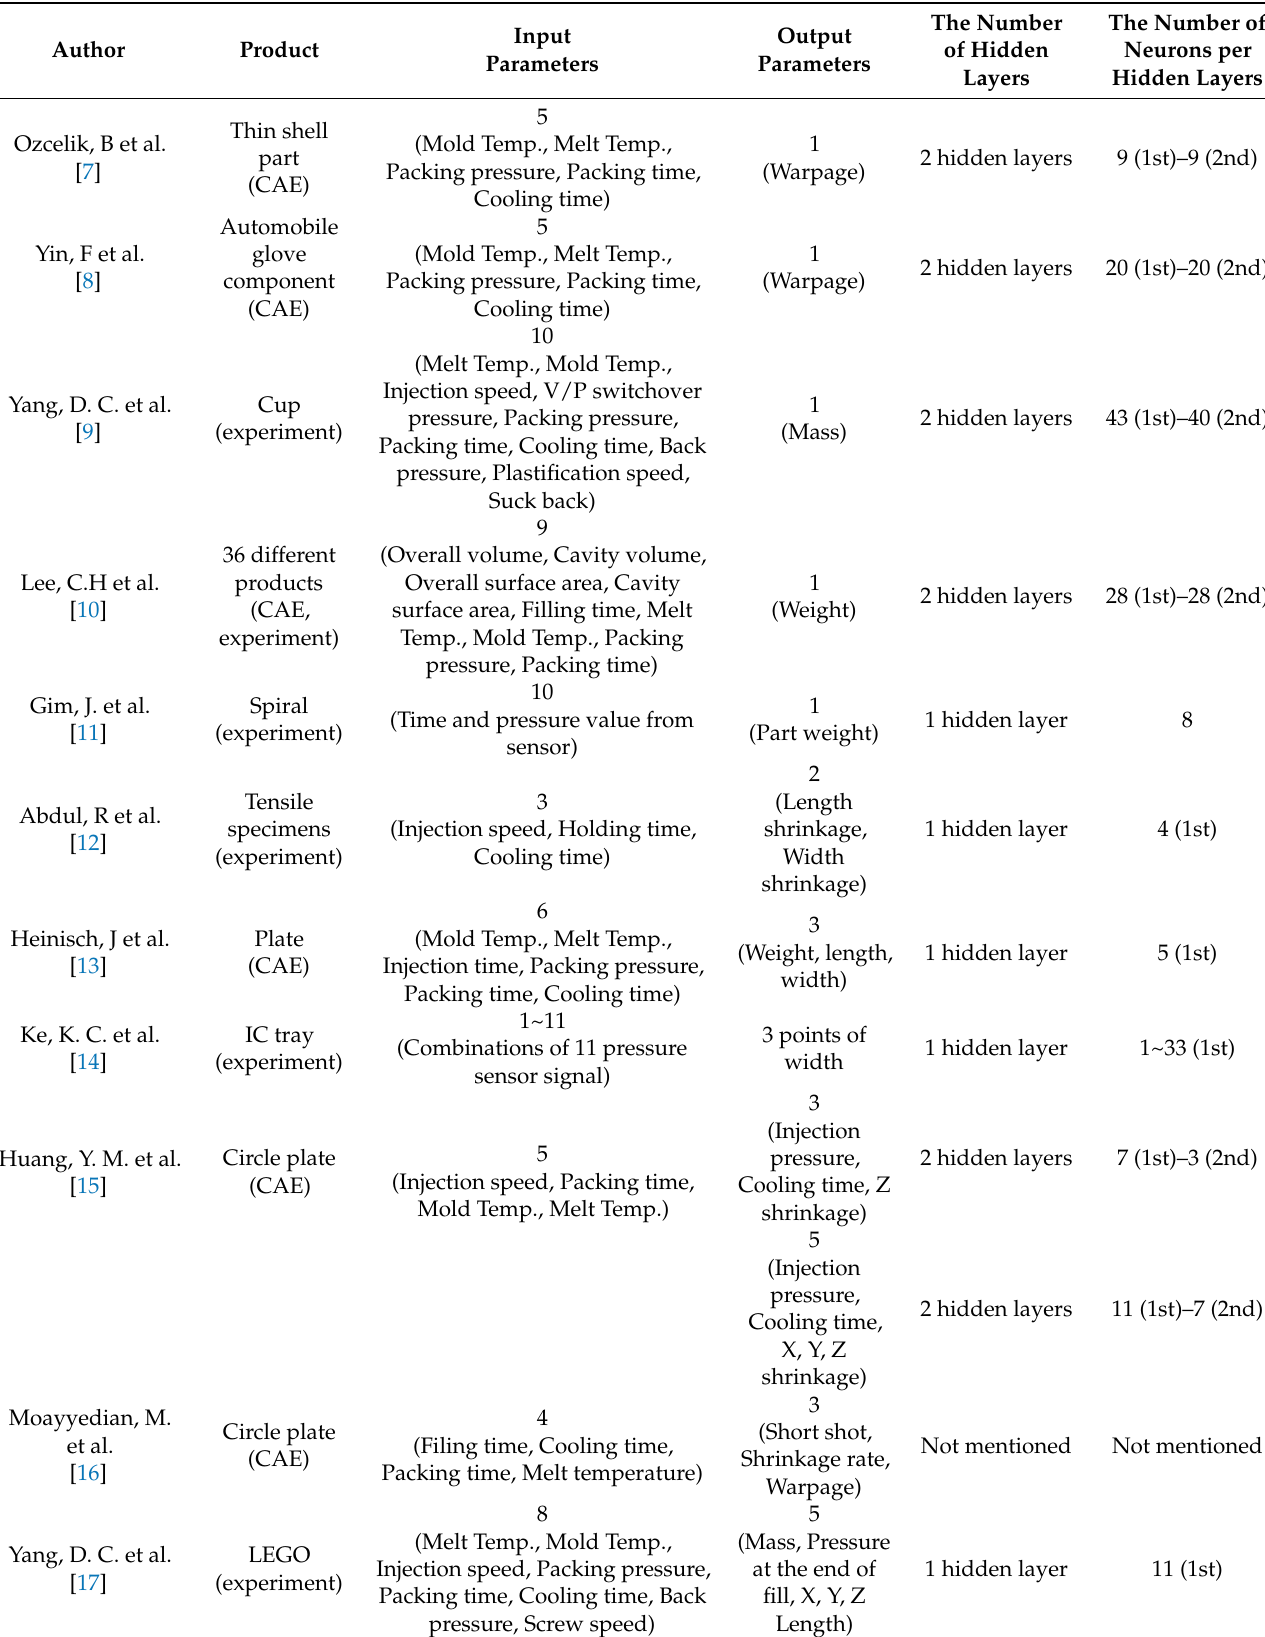
Table 1. Previous research on ANNs applied to the injection molding process